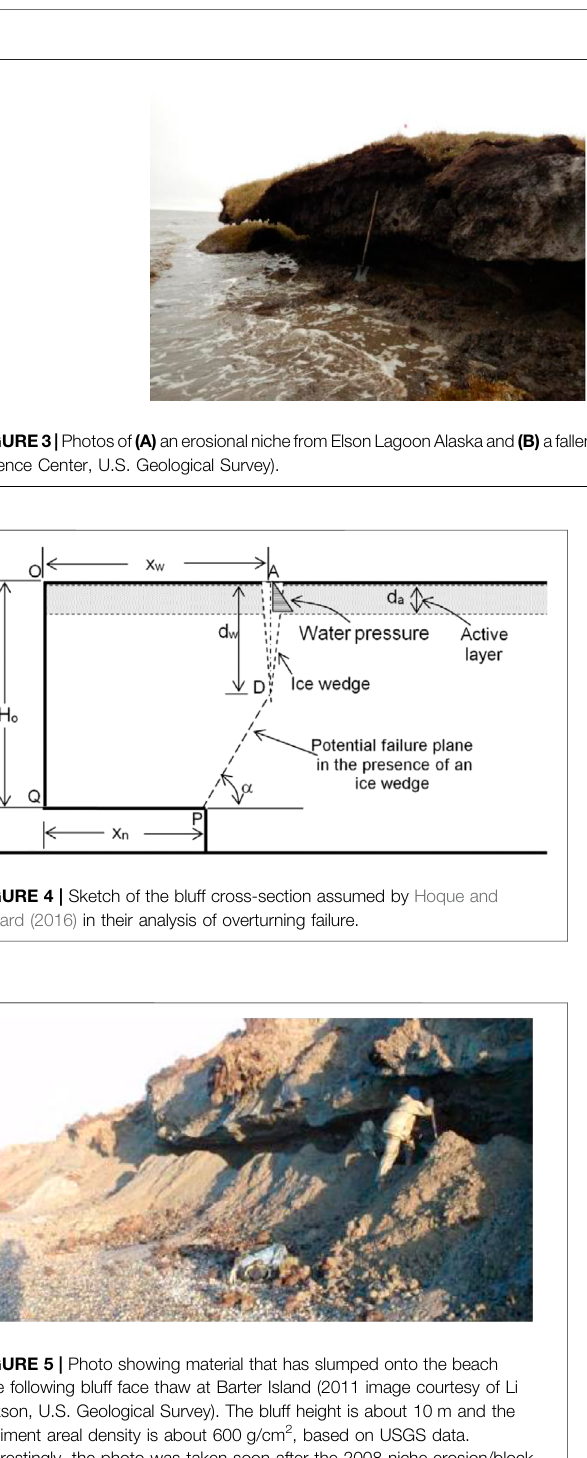
Frontiers in Earth Science |